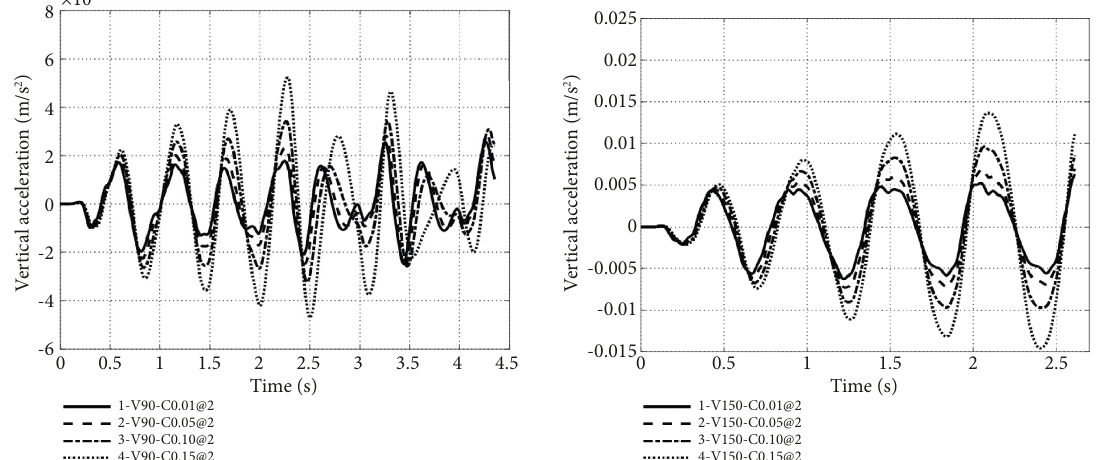
Figure 15: Vertical acceleration response of pickup point under change of damper ratio of vibration isolator.